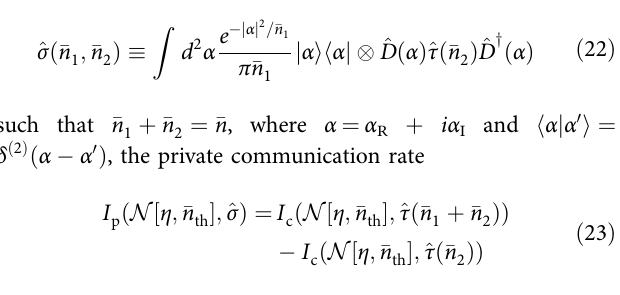
1 (cid:2) subject to the maximum allowed average photon number ( a ) (cid:2) n ¼ 0 : 5 ( b ) (cid:2) n ¼ 1 ( c ) (cid:2) n ¼ 1 : 5 per channel use. In a – c , th ¼ η ; (cid:2) n ; ^ τ ð (cid:2) n ÞÞ and the reverse coherent information I η ; (cid:2) n ; ^ τ ð (cid:2) n ÞÞ with c ðN½ th (cid:2) rc ðN½ th (cid:2) (cid:2) n (see ; (cid:2) n ? xI η ; (cid:2) n ; ^ τ ð (cid:2) n x Þ I η ; (cid:2) n ; ^ τ ð (cid:2) n ≤ x ≤ 1 and x (cid:2) n x Þ (cid:2) n 1 ÞÞ þ ð 1 (cid:6) 2 ÞÞ(cid:2) subject to 0 1 þ ð 1 (cid:6) 2 ¼ 1 2 Þ ¼ argmax x ; (cid:2) n 1 ; (cid:2) n 2 ½ c ðN½ th (cid:2) rc ðN½ th (cid:2) and (cid:2) n ? are, respectively, represented by the blue and yellow lines for ( d ) (cid:2) n ¼ 0 : 5 ( e ) (cid:2) n ¼ 1 ( f ) (cid:2) n ¼ 1 : 5. 1 2